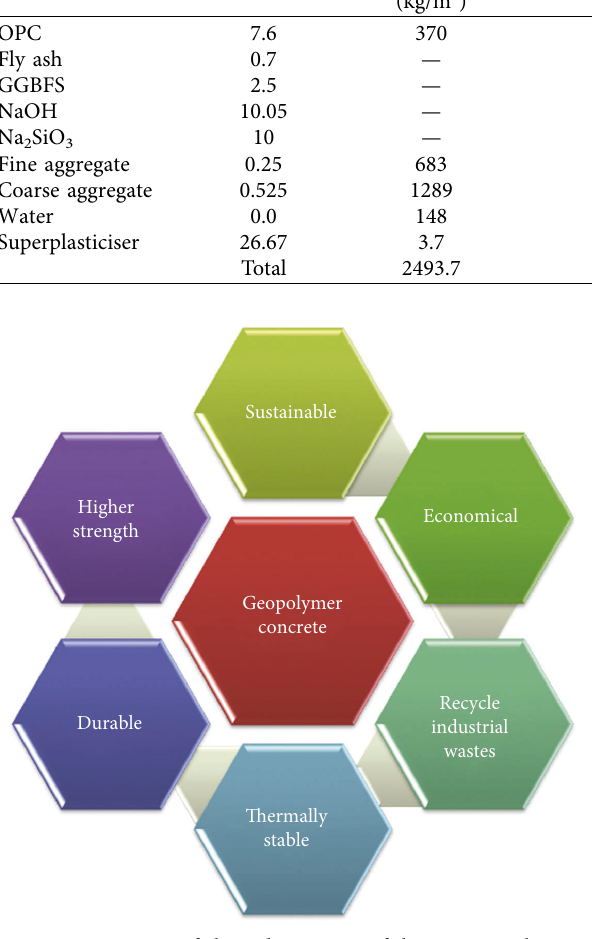
Figure 11: Picture of short description of the GPC